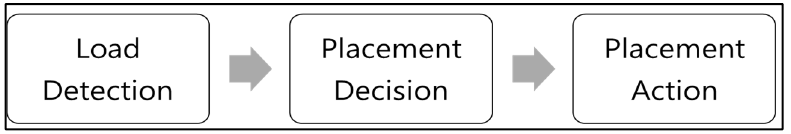
Figure 1. Placement process.